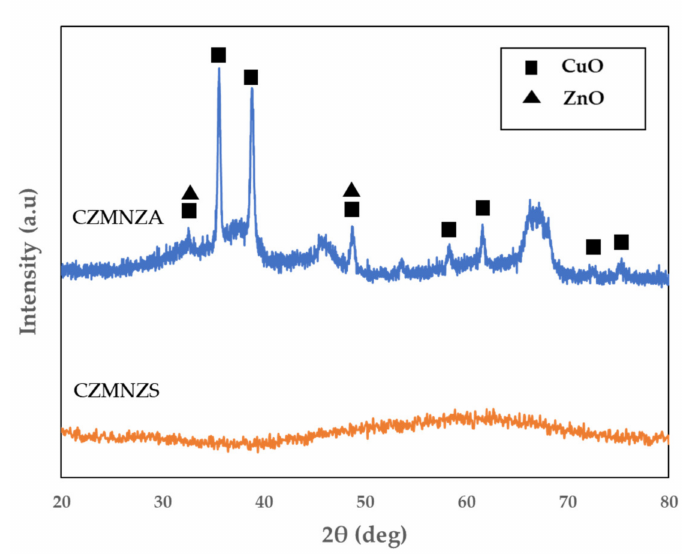
Figure 9. XRD patterns of CZMNZA and CZMNZS.